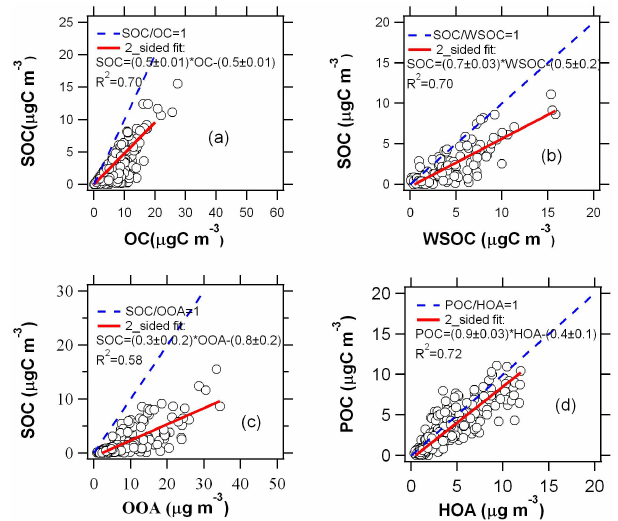
Fig. 7. (a) Scatter plot between OC and EC during the nights of local primary emission days. (b) R 2 between SOC and EC is as a function of the primary emission ratio between OC and EC in the local emission influence days and (c) normal days of the whole campaign.